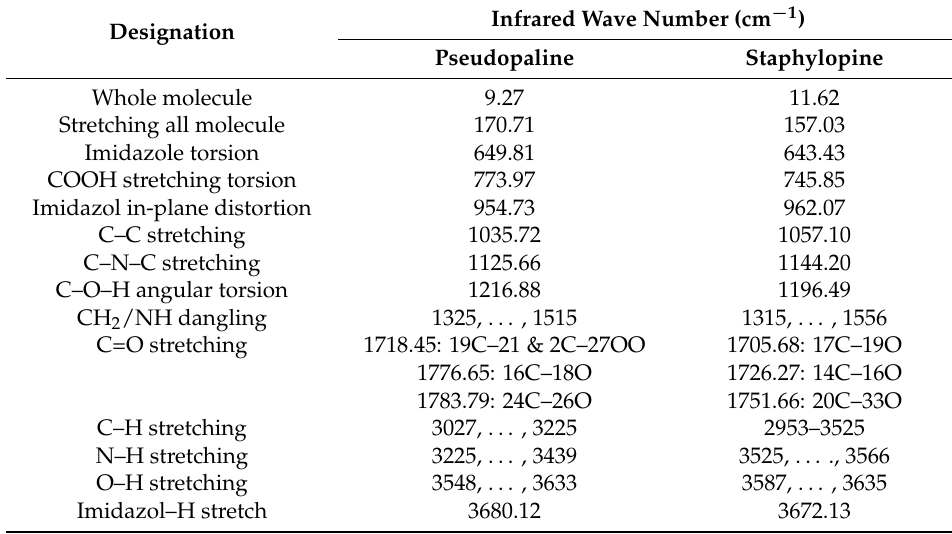
Figure 2. The molecules of both metallophores under consideration—pseudopaline and staphylopine—and their FMOs, highlighting the active centers. Chelating centers were created upon removing two hydroxyl H. Notice the resemblance with the deferasirox active chelating center (Figure 1a). The numbering of some C and O atoms were used in Table 1 to assign vibrations. Table 1. Main infrared (IR) frequencies in pseudopaline and staphylopine obtained from the B3LYP/6-31g quantum molecular calculations. The numbering of some C and O atoms is as shown in Figure 2.